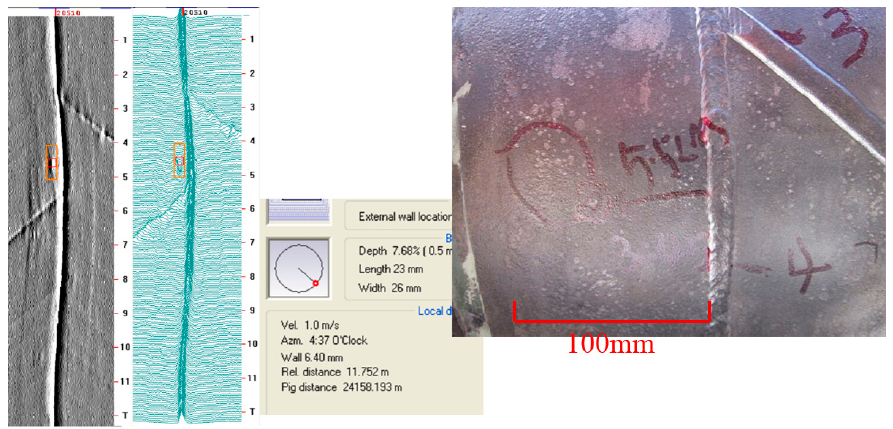
Figure 8. The corrosion signals and picture with riverside pattern.